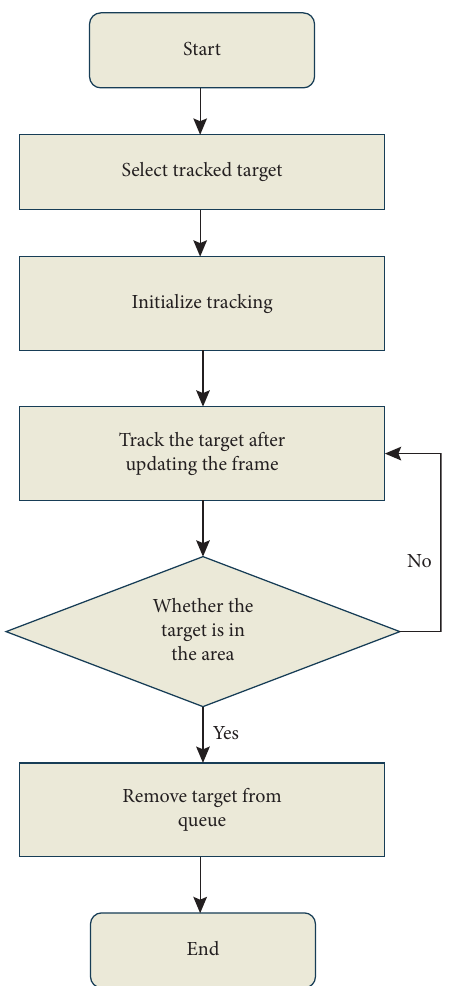
Figure 12: Multitarget tracking Table 1: Statistical table of processing speed in the direct fusion mode (frames/sec).